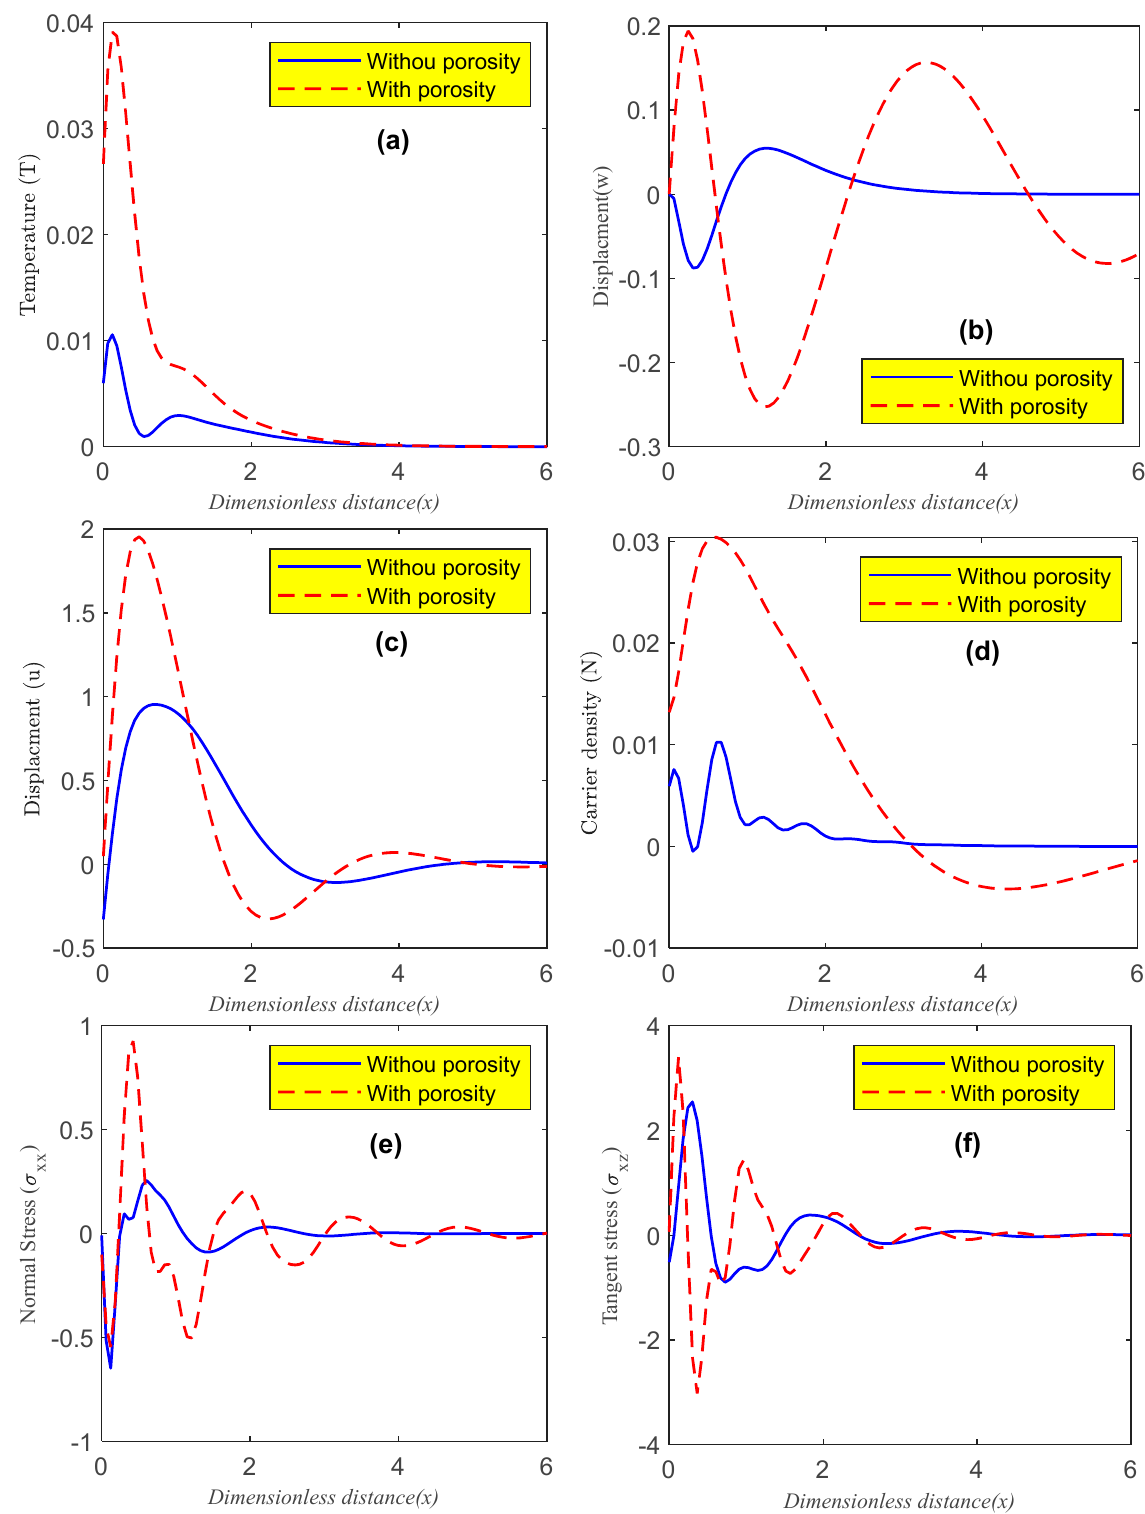
Figure 2. ( a–f ) Variation of the main physical distributions w.r.t the distance for different two cases of porosity under the impact of GL model.